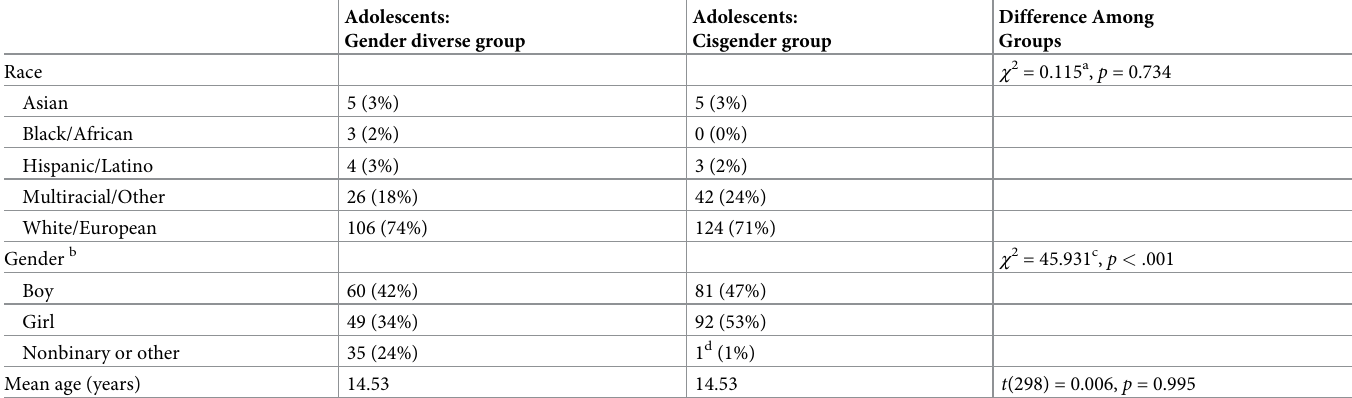
Table 2. Demographic breakdown of adolescent